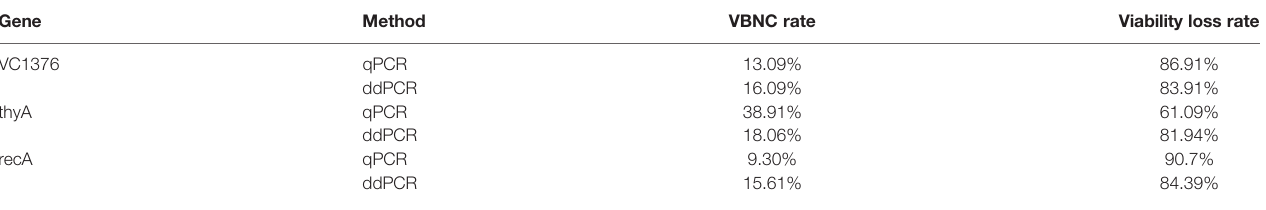
TABLE 3 | Assessment of viability loss rate of V. cholerae strain C6706 on day 70 of VBNC-state development by quanti fi cation of VC1376, thyA , and recA by qPCR and